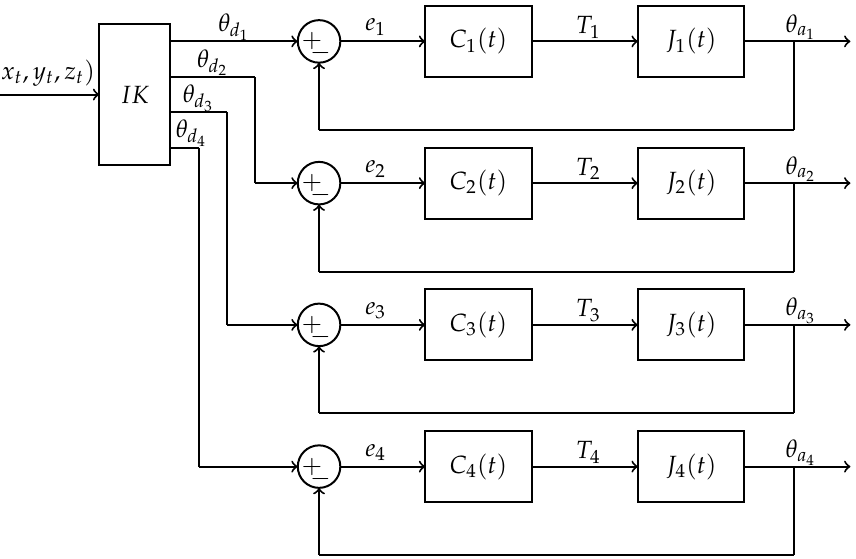
Figure 5. Block diagram of control system for each